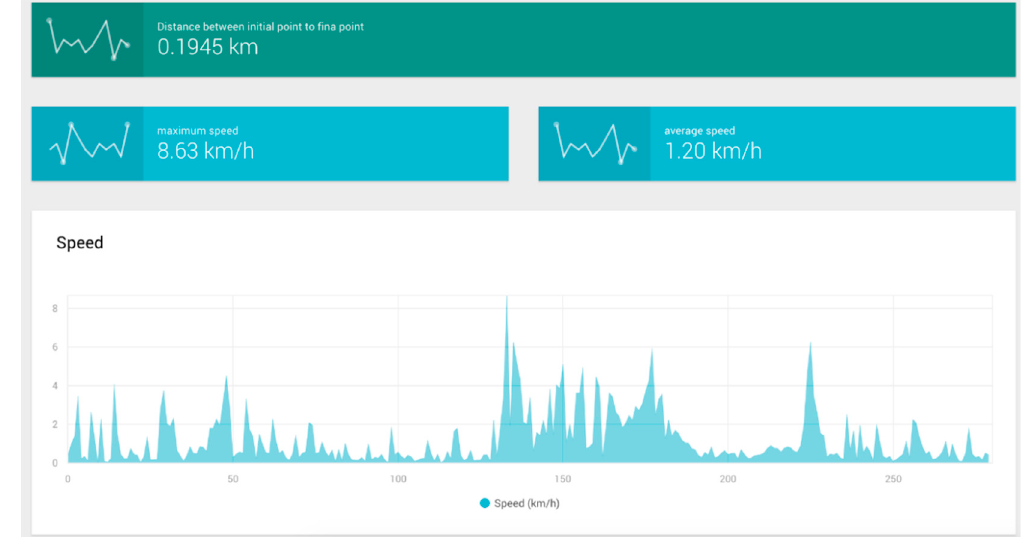
Figure 22. Mobile node speed-related data.